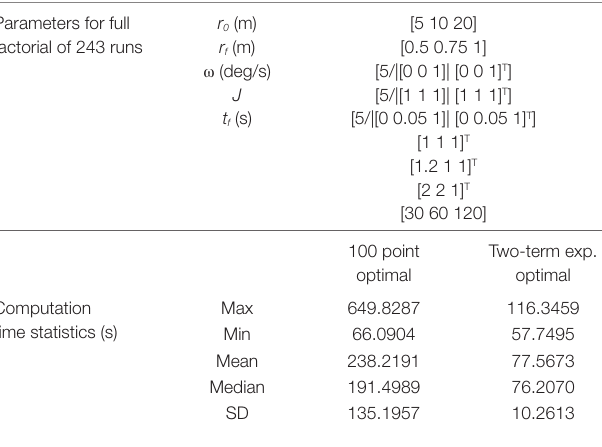
Table 3 | Comparison of computation times required for both 100 point optimal and two-term exponential trajectories for specified parameters for 243 simulated